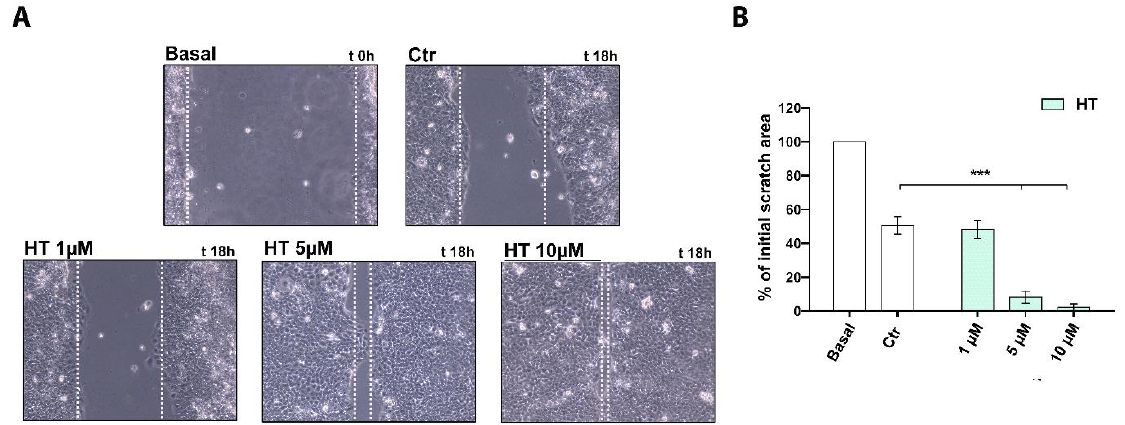
Figure 3. Improvement of the migratory capacity of HaCaT cells exposed to HT. ( A ) Wound healing assay was carried out in HaCaT cells treated for 18 h with HT (1–10 µ M) in complete medium. Light microscope images shown are representative of four independent experiments. Dotted white lines indicate the wounded area from the initial scratch. Magnification × 200; ( B ) Bar columns correspond to the mean scratch area expressed as percentage respect to basal time point area. The measurement was carried out in four different experiments. Results are shown as mean ( ± SD) (2-way ANOVA, *** p <